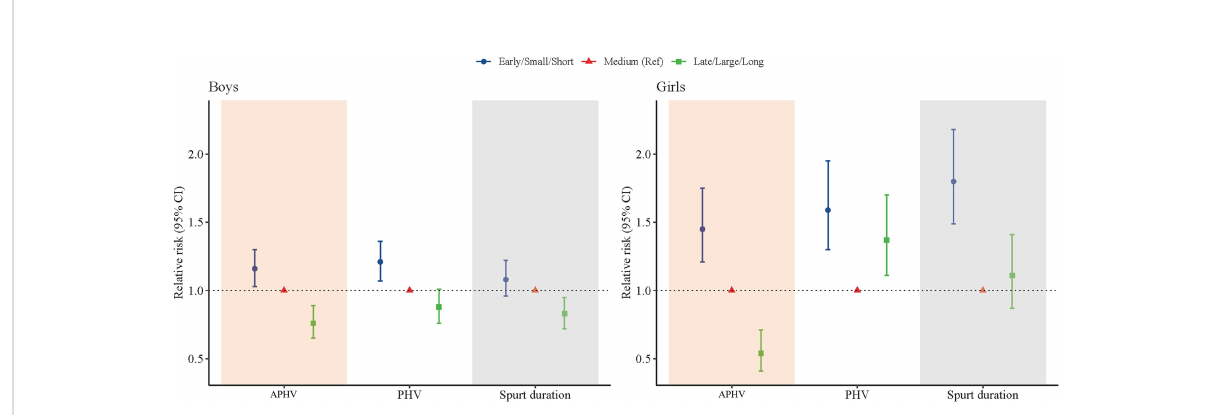
FIGURE 5 Association between height growth patterns and overweight and obesity in late adolescence of Chinese children and